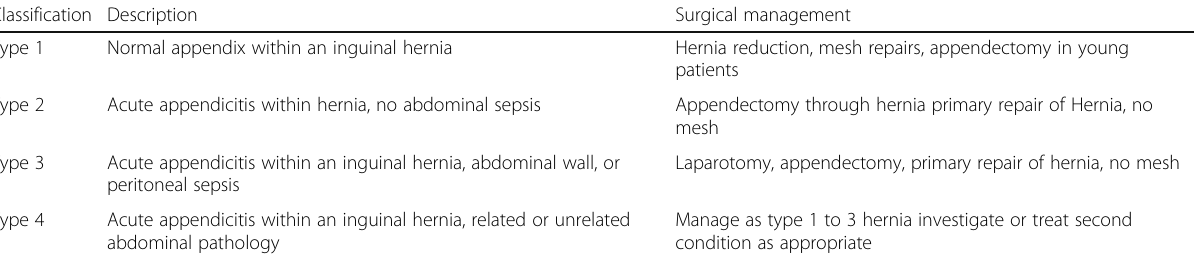
Table 1 Types of Amyand hernias and their management